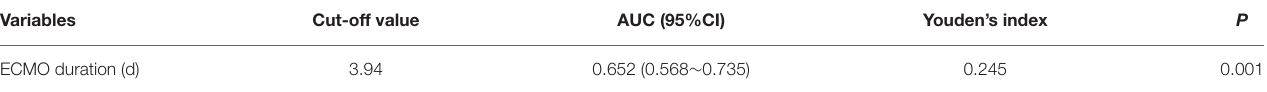
TABLE 3 | The specific results of ROC Curve. Variables Cut-off value AUC (95%CI) Youden’s index ECMO duration (d)